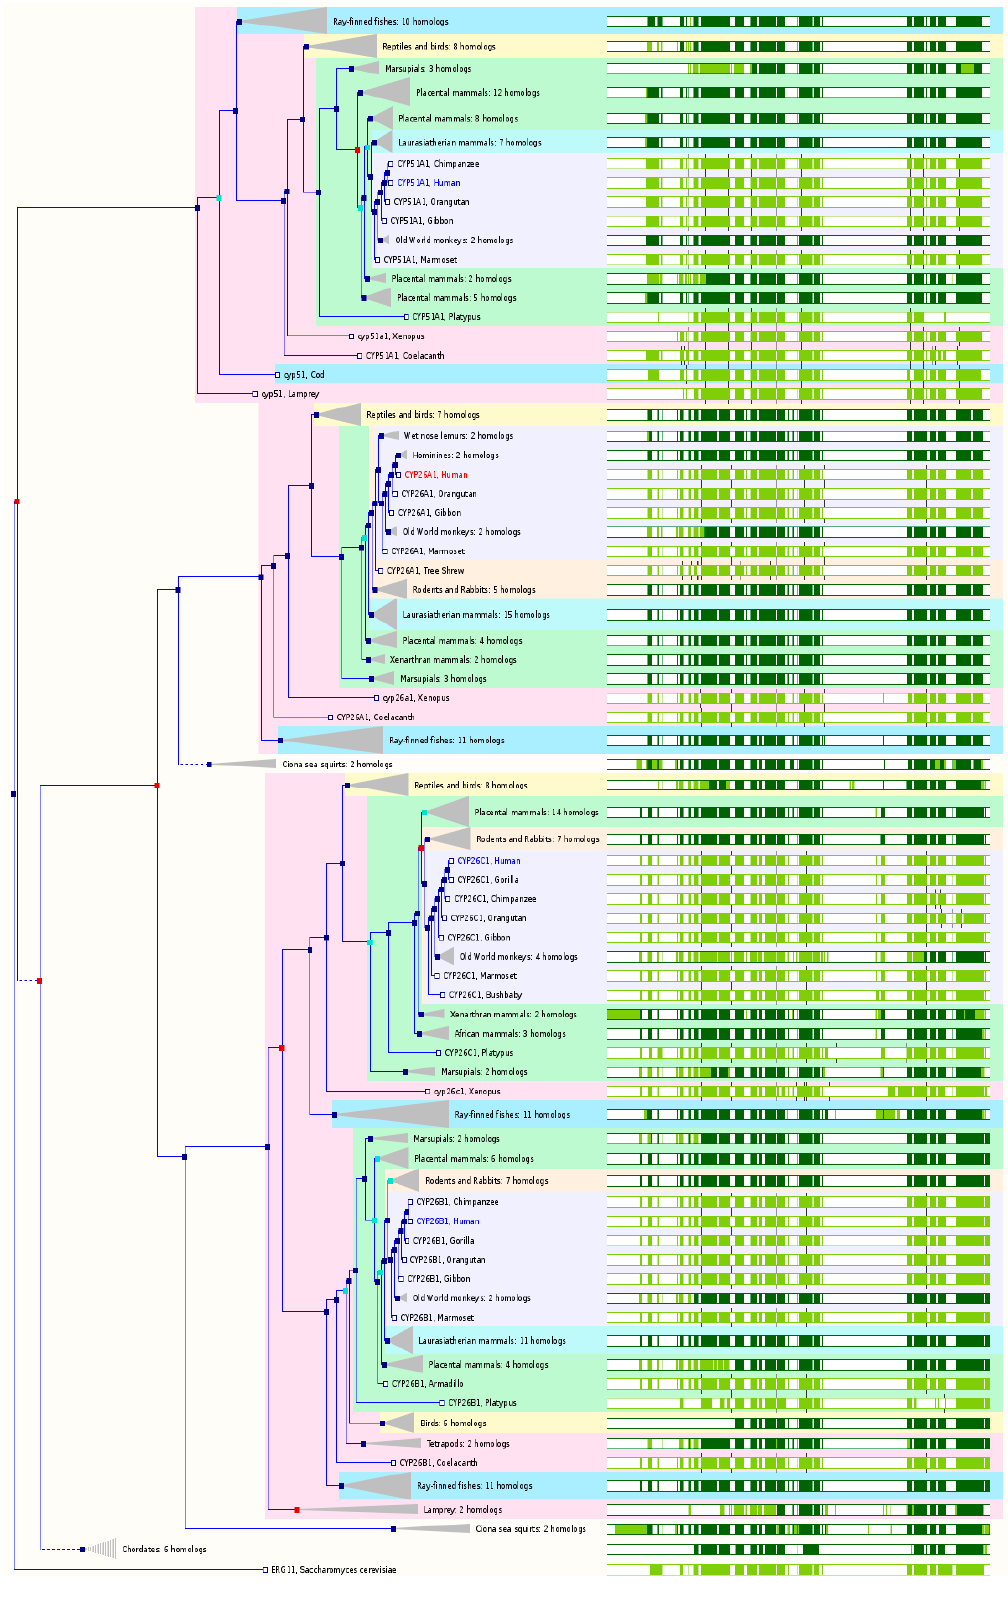
Figure 7. Cont. Figure 7.